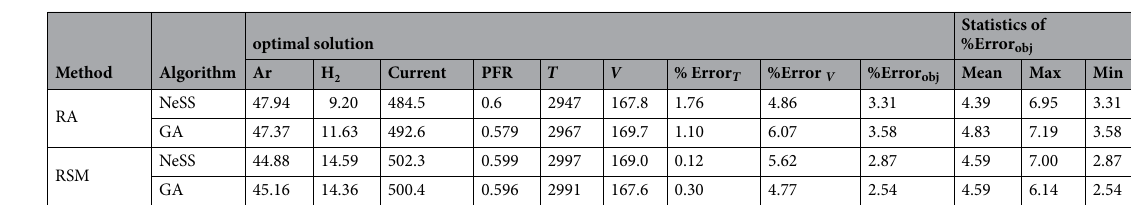
Table 4. Optimal input parameters from the NeSS and the GA for the desired MPCs (3000 K, 160 m/s).